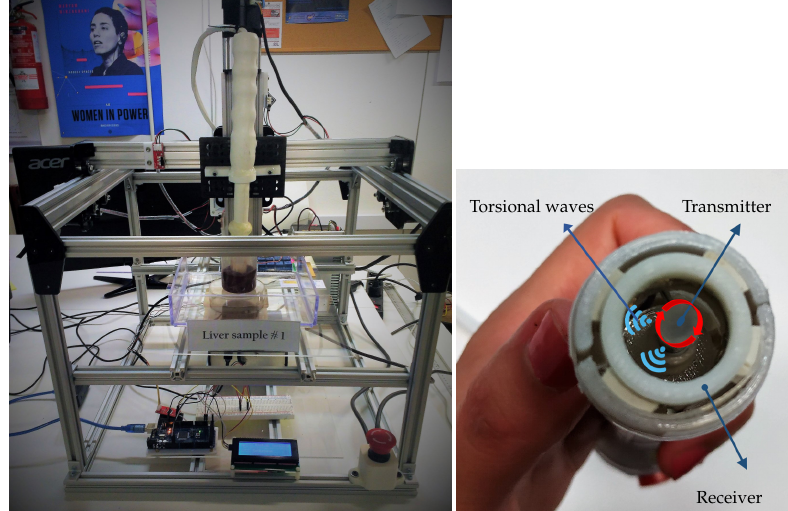
Figure 3. Set-up for measurements using TWE technique. The picture was taken during the measurements at the Ultrasonics Lab at the University of Granada. The figure on the left is a computer numerical control (CNC) system for positioning and pressure-control of the TWE probe. The right figure shows a cross-section of the TWE